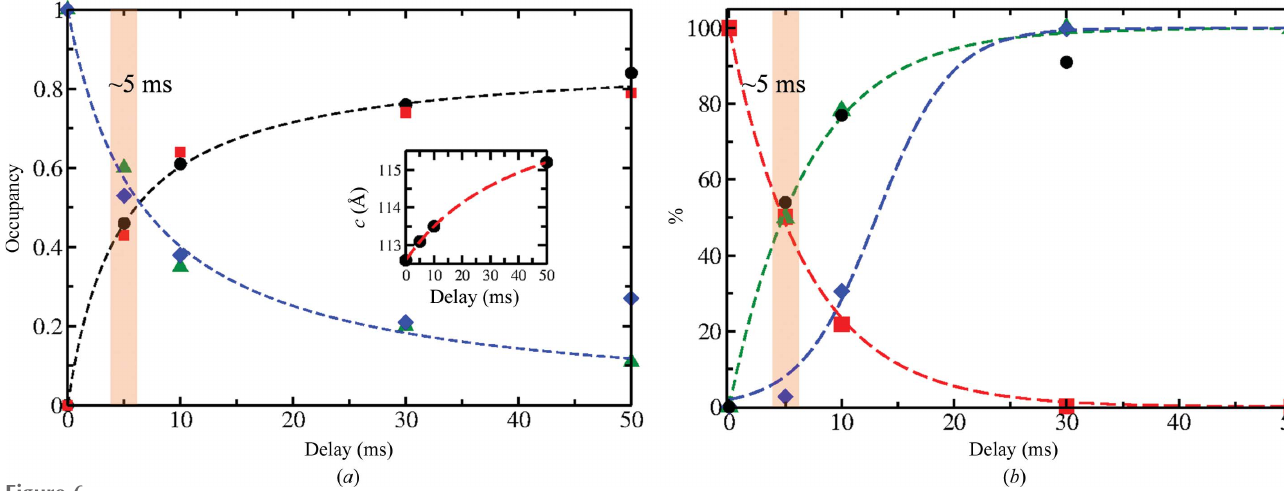
Figure 6 BlaC–CEF complex formation as a function of time. ( a ) Occupancies of CEF in the active site of BlaC at 5, 10, 30 and 50 ms in subunits B (spheres) and D (squares) as well as those of P i (green triangles and blue diamonds) are plotted as a function of delay (the 30 ms data are from Olmos et al. , 2018). The data are fitted with saturation curves [equations (1) and (2), black and blue dashed lines]. The two curves intersect at around 6 ms. Inset: the corresponding change in the unit-cell axis c . ( b ) Concentrations (in %) as calculated from diffusion and binding [equations (1)–(5)]; green dashed line and green triangles, increase of the calculated BlaC–CEF complex concentration averaged over all voxels in the crystal; red dashed line and squares, decrease of the free enzyme (BlaC); blue dashed line and diamonds, increase of the BlaC–CEF complex in the center of the platelet-shaped crystals. For comparison, the observed (refined) occupancies of the BlaC–CEF complex (normalized to 100% at 50 ms) are also shown (black spheres).